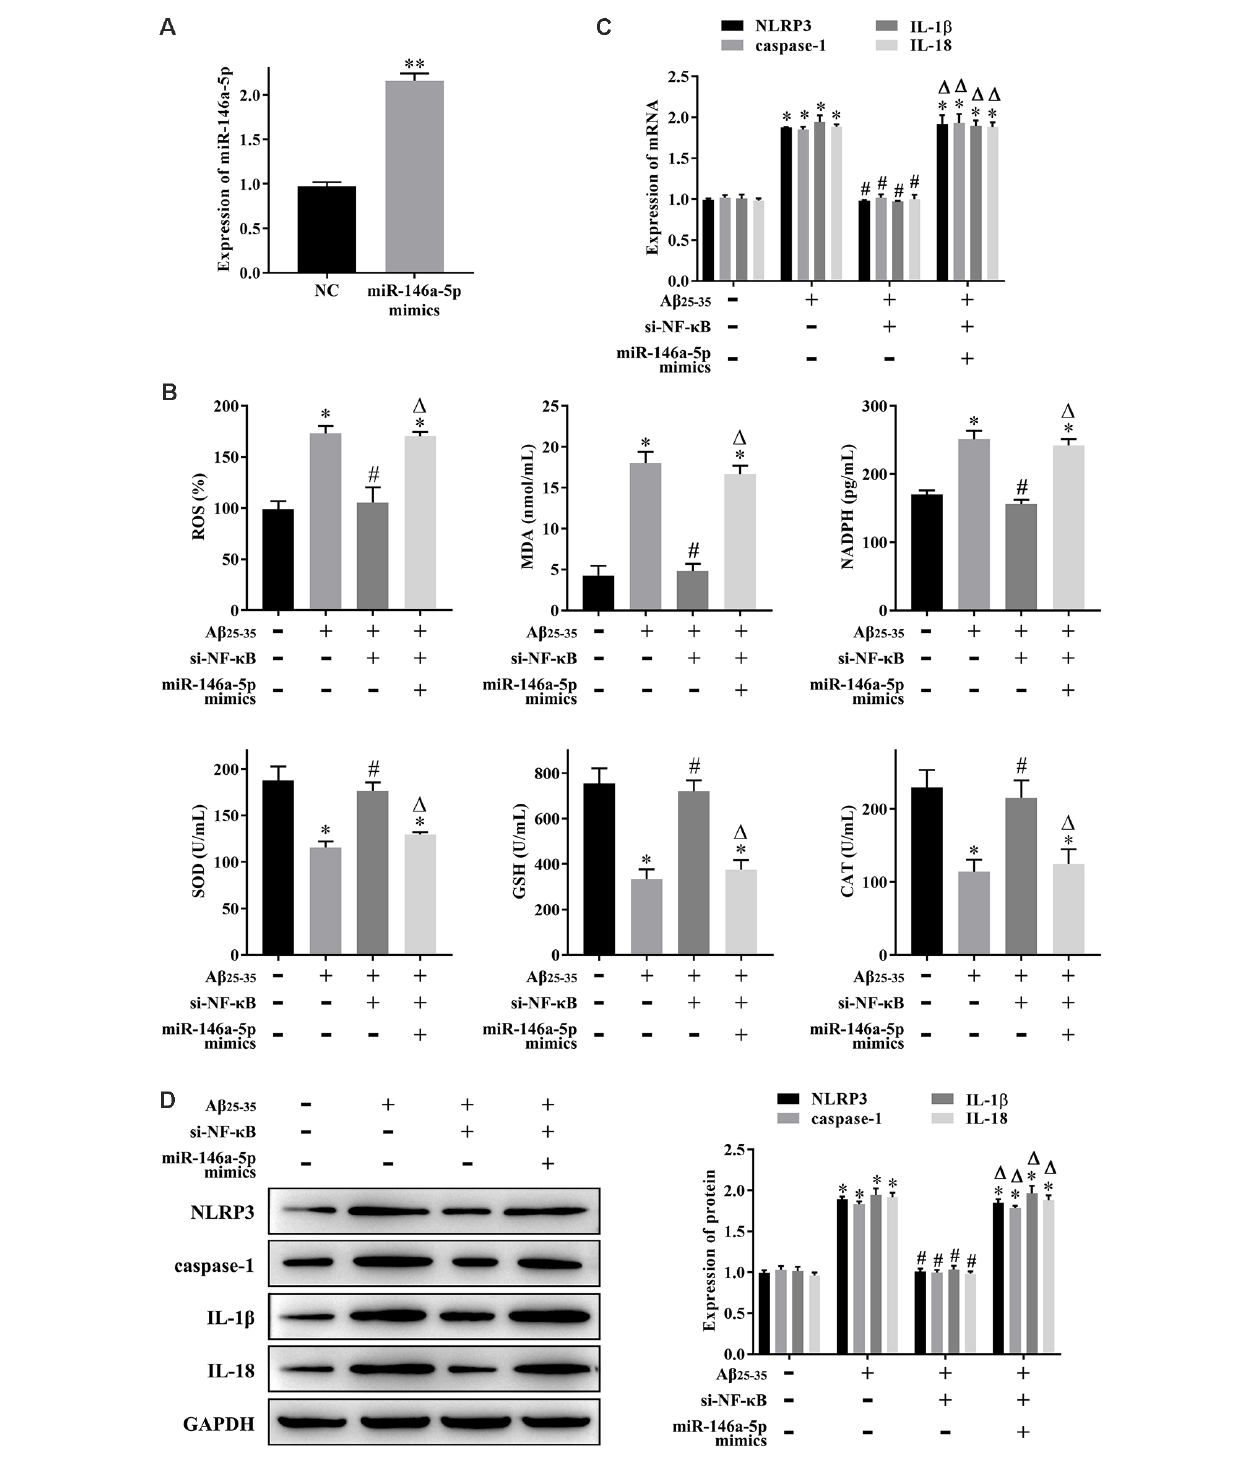
FIGURE 2 | NF- κ B promotes oxidative stress and pyroptosis in a cell culture model of Alzheimer’s disease in human hippocampal neurons (AD-HNNs) via miR-146a-5p. (A) Transfection efficiency of miR-146a-5p mimics into AD-HNNs. ∗∗ P < 0.01 vs. NC group. (B) Level of oxidative stress indices [reactive oxygen species (ROS), malondialdehyde (MDA), nicotinamide adenine dinucleotide phosphate (NADPH), superoxide dismutase (SOD), glutathione (GSH), and catalase (CAT)]. (C) mRNA expression of pyroptosis markers (NLRP3, caspase-1, Interleukin (IL)-1 β , and IL-18). (D) Protein expression of pyroptosis markers (NLRP3, caspase-1, IL-1 β , and IL-18). ∗ P < 0.05 vs. HHN group; # P < 0.05 vs. AD-HHN group; ∆ P < 0.05 vs. AD-HHN+si-NF- κ B group.